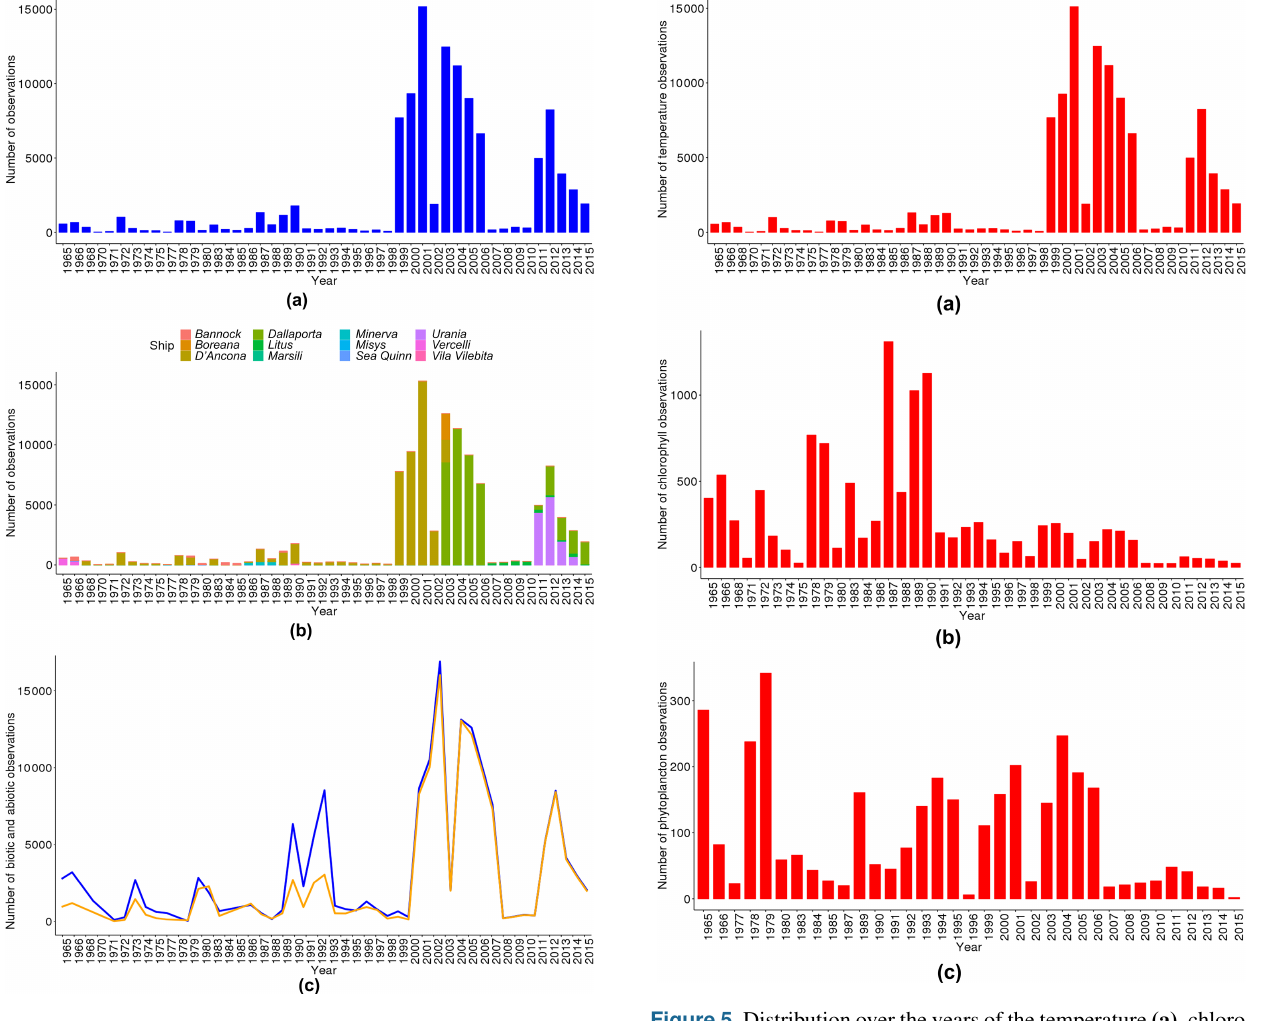
Figure 4. Total number of observations over the whole period (a) , clustered by research vessel (b) and by biotic (orange line) and abi- otic (blue line) parameters (c) .